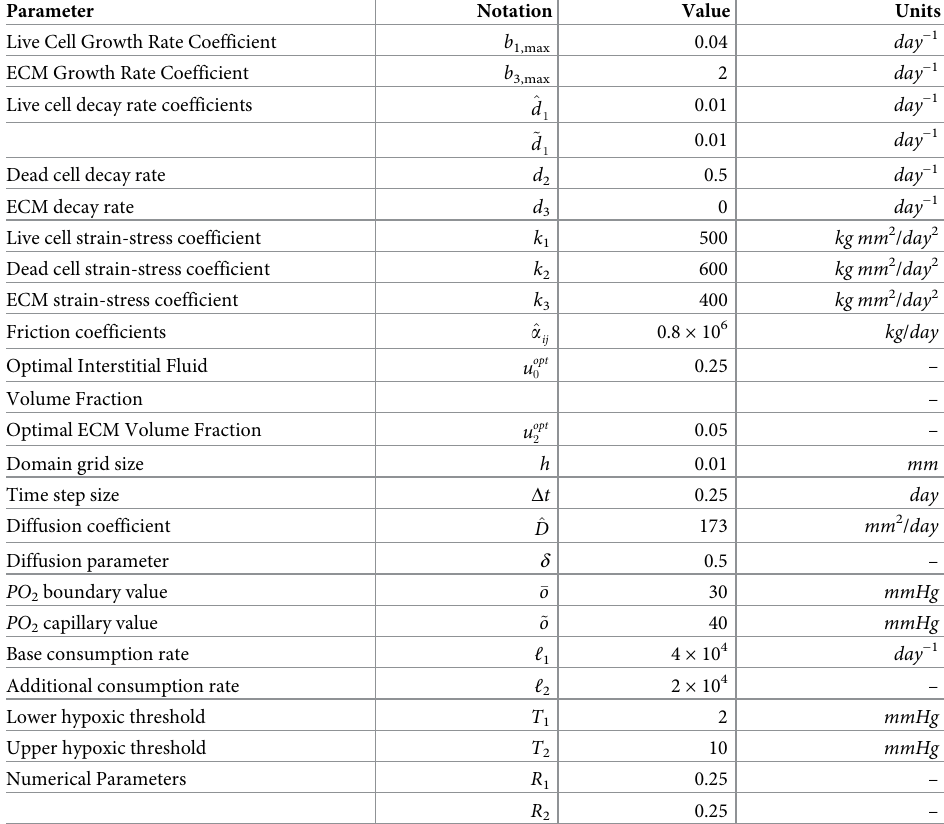
Table 2. Default parameter values for the experiments in tissue regeneration model in the presence of vascular network.